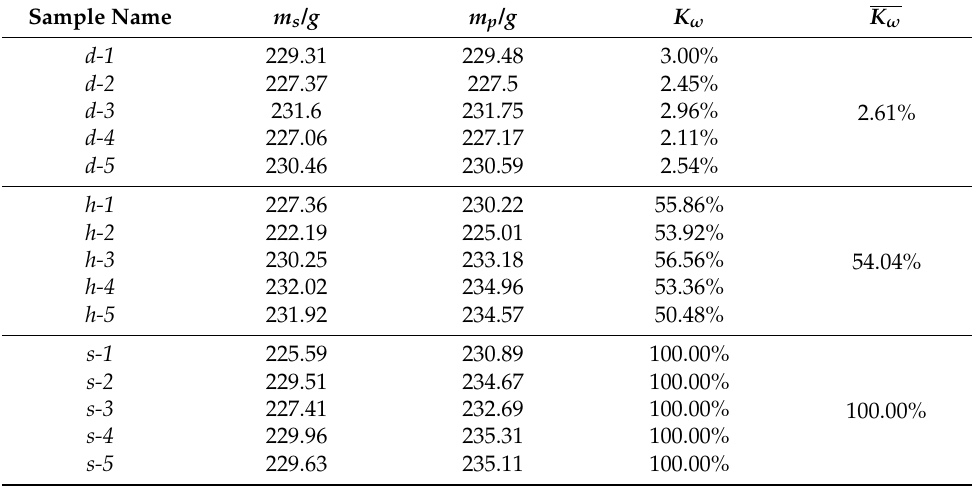
Table 1. Rock specimen saturation.